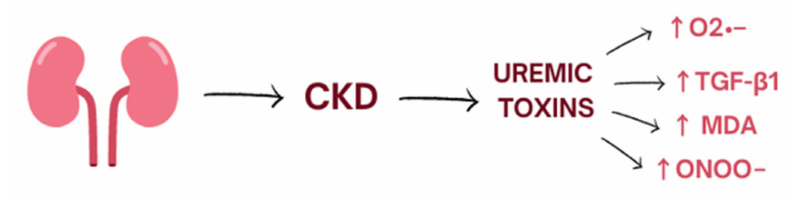
Figure 1. The influence of uremic toxins on the level of oxidative stress. CKD, chronic kidney disease. Formation of ROS or changes in ROS production can occur in both the renal cortex and medulla which cause alteration in renal blood flow over sodium/fluid retention to inflammation and fibrotic changes and onset of proteinuria